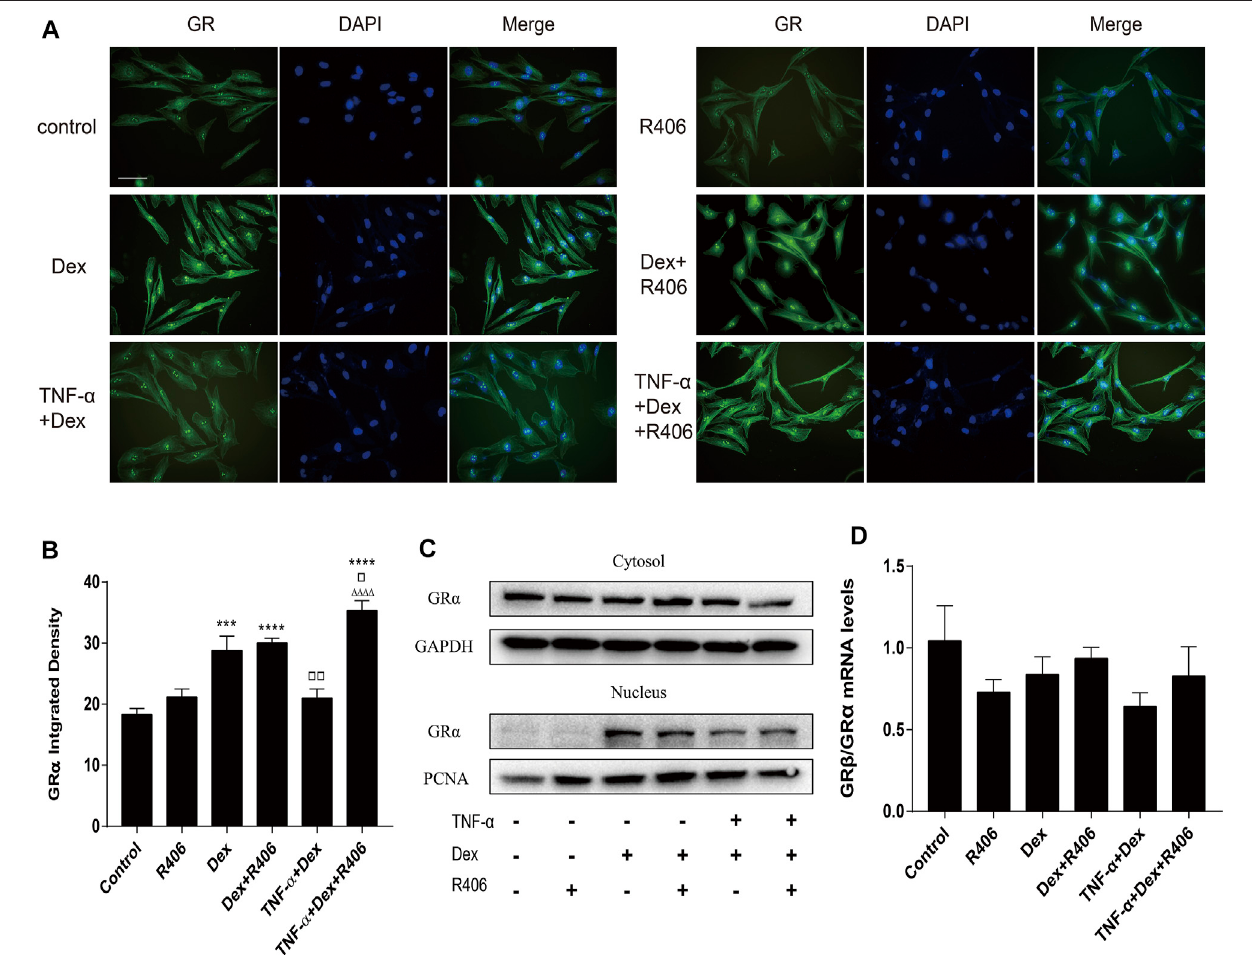
FIGURE5| TheSykinhibitorR406improvesTNF- α -inducedGR α nucleartranslocationwithoutaffectingtheGR β /GR α ratio. (A – C) BEAS-2Bcellswerepretreated withR406(1 μ M)for30 minandincubatedwithDex(1 μ M)orwithDex(1 μ M)plus TNF- α (10 ng/ml)for12 h.GR α wasdyedgreen,and thecellnucleiwerestainedwith DAPI(blue).TheexpressionanddistributionofGR α incellswereanalyzedbyimmuno fl uorescence (A,B) andWesternblotting (C) . (D) ThemRNAlevelsofGR β andGR α relativetoGAPDHweremeasured byqPCR. n =3/group,Scalebar=50 μ M;*** p < 0.001,** p < 0.0001,compared withthecontrolgroup; ▫ p < 0.05, ▫▫ p < 0.01, compared with the Dex group; △△△△ p < 0.0001, compared with the TNF- α +Dex